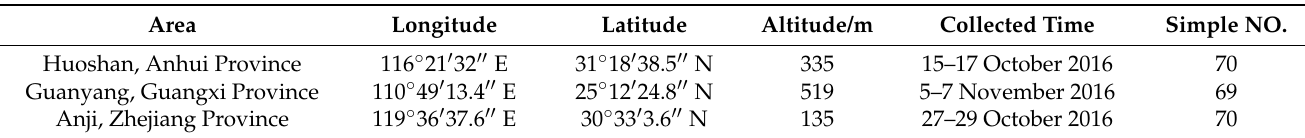
Table 1. Geographical longitude, latitude, and altitude of Moso bamboo ( Phyllostachys edulis ) in 3